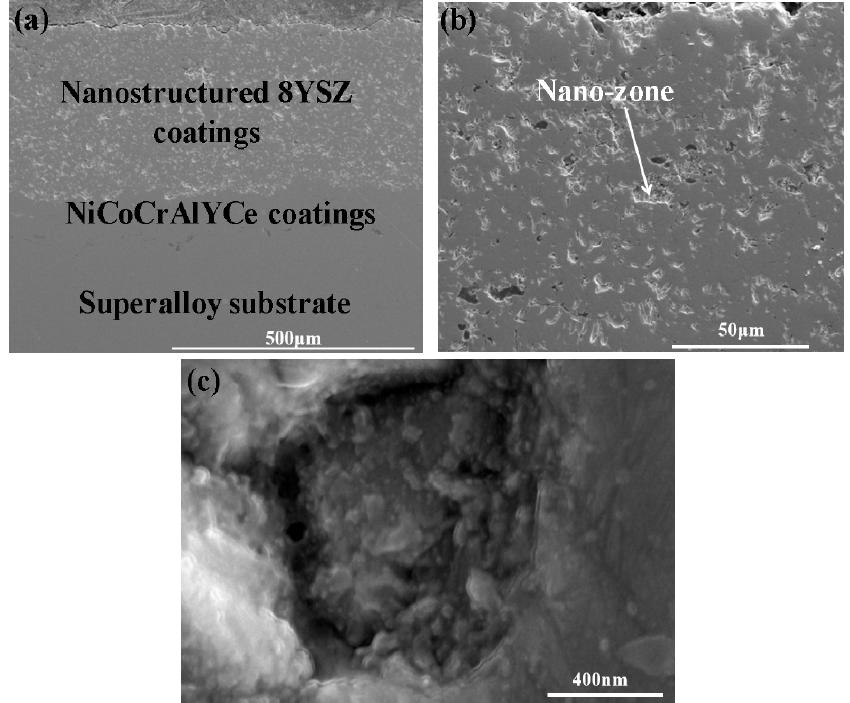
Figure 1. ( a ) Cross sectional SEM images of as-sprayed 8YSZ coatings, ( b ) magnified image of ( a ), and ( c ) magnified image of unmelted feedstocks in ( b ).